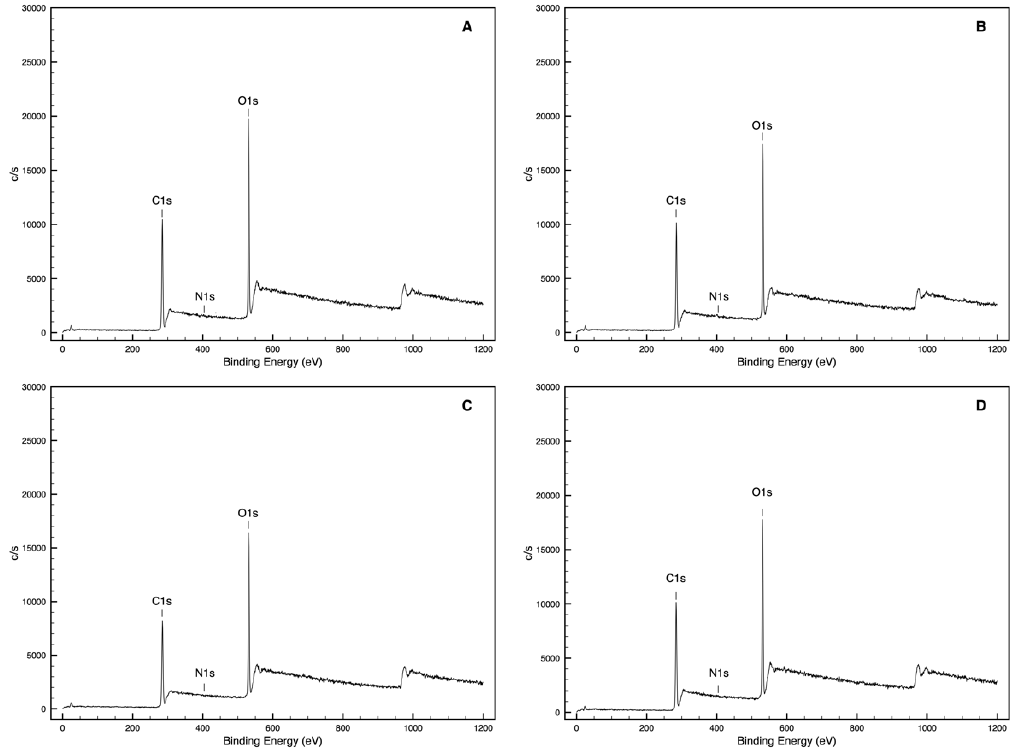
Figure A3. XPS survey scan of cellulose/polyester nonwoven wipe (W2), A) W2R, B) W2RQ, C) W2P, D) W2PQ.